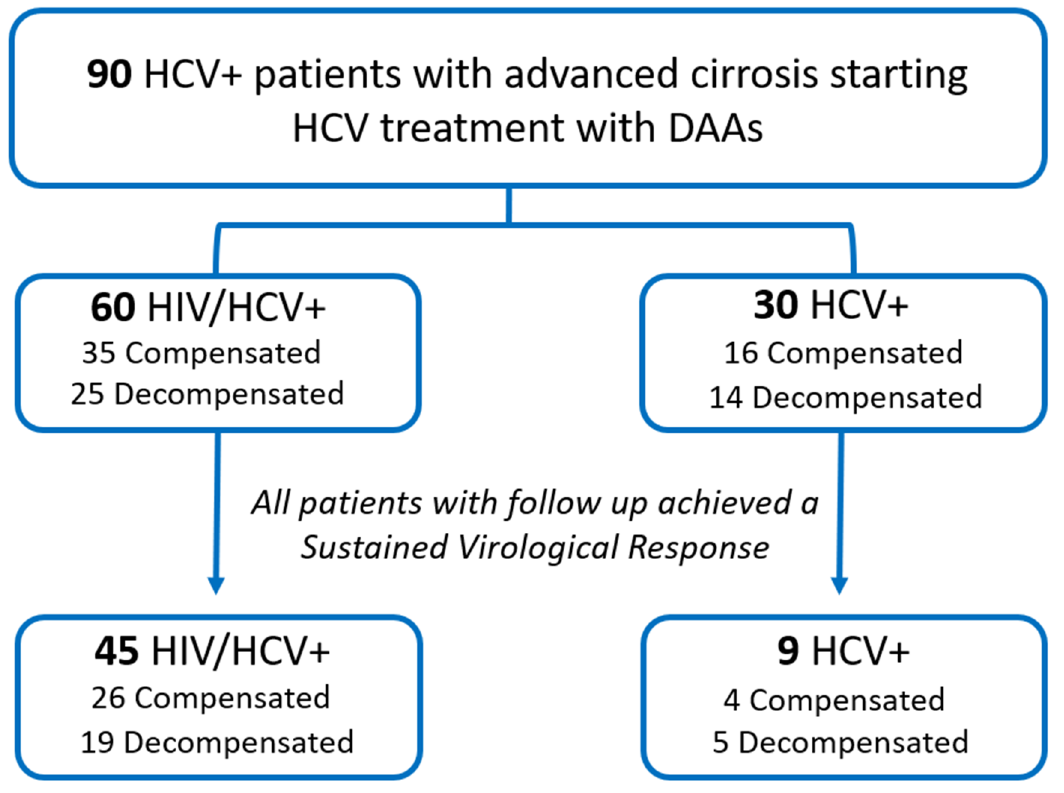
Figure 1. Flow chart of patient selection. Stratification according to decompensation is referred to at the baseline.